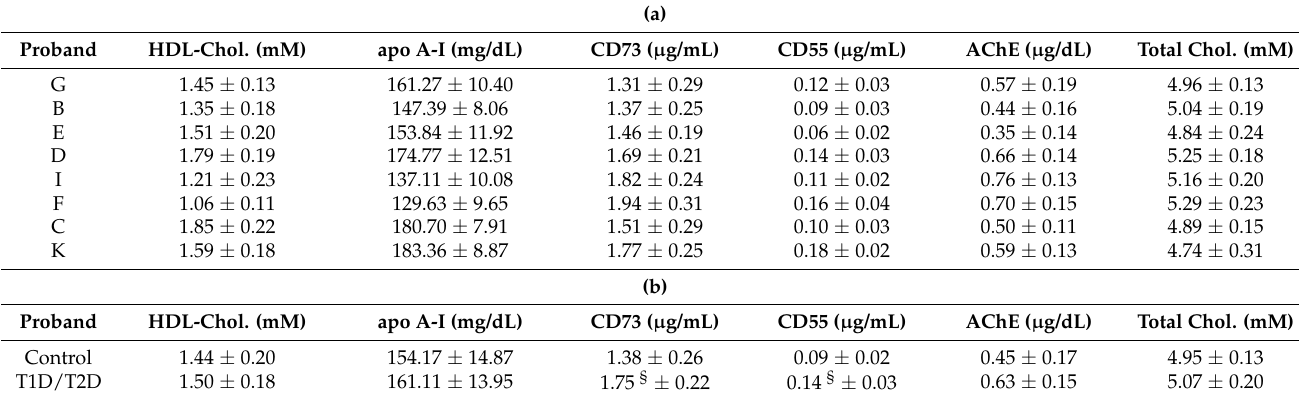
Table 3. Characteristics of plasma HDL from the human probands. HDLs isolated from plasma samples were assayed for the presence of cholesterol (HDL-Chol.), apo A-I, CD73, CD55, and AChE as described in Materials and Methods. Furthermore, total plasma cholesterol (Total Chol.) was determined. ( a ) Means ± SD of four independent measurements each are given. ( b ) Means ± SD of control probands (G, B, E) and T1D/T2D probands (D, I, F, C, K) ( § p ≤ 0.05 for T1D/T2D vs. Control) are